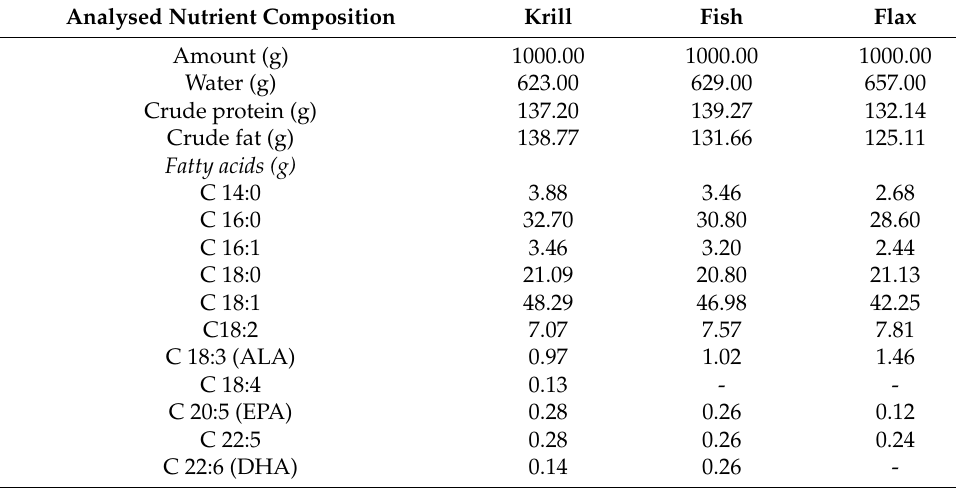
Table 4. Calculated nutritional average daily intake (g) of treatment diets. Analysed Nutrient